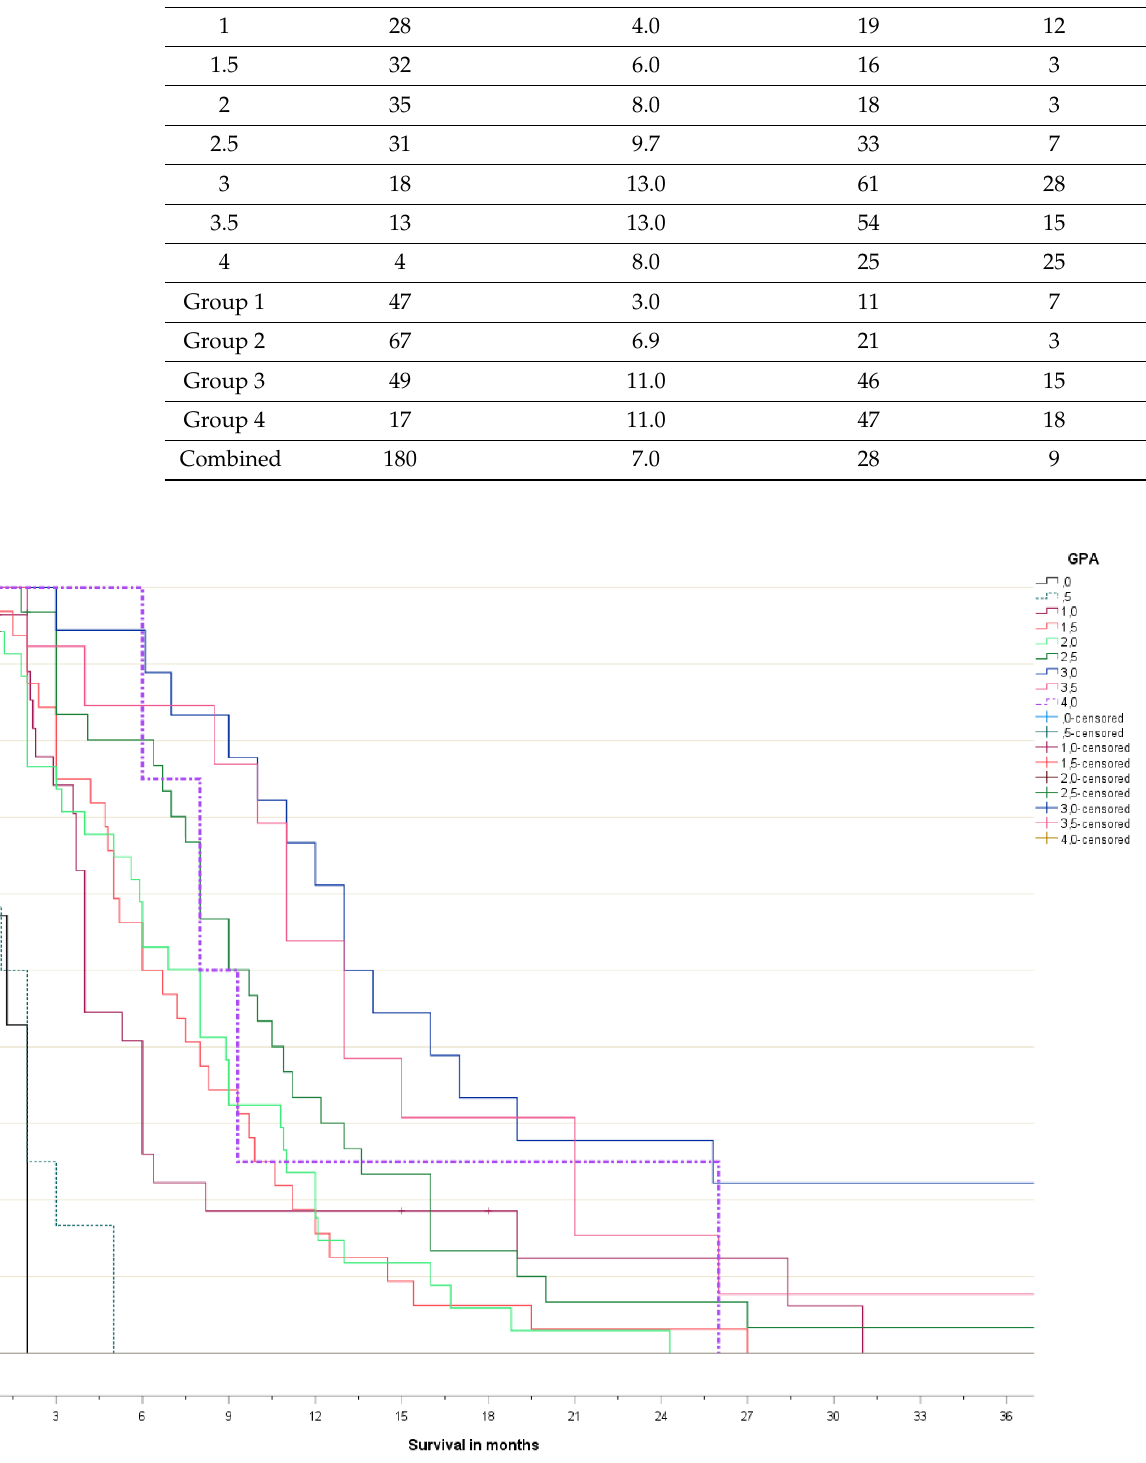
Figure 1. Actuarial overall survival (Kaplan-Meier curves, log-rank test pooled over all strata p < 0.001).